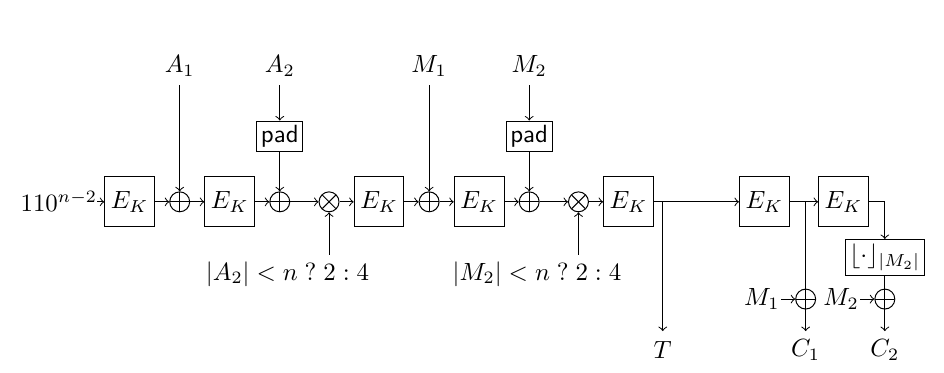
Figure 2: The authenticated encryption scheme SUNDAE (Section 4.1), for 0 < | A | ≤ 2 n and 0 < | M | ≤ 2 n